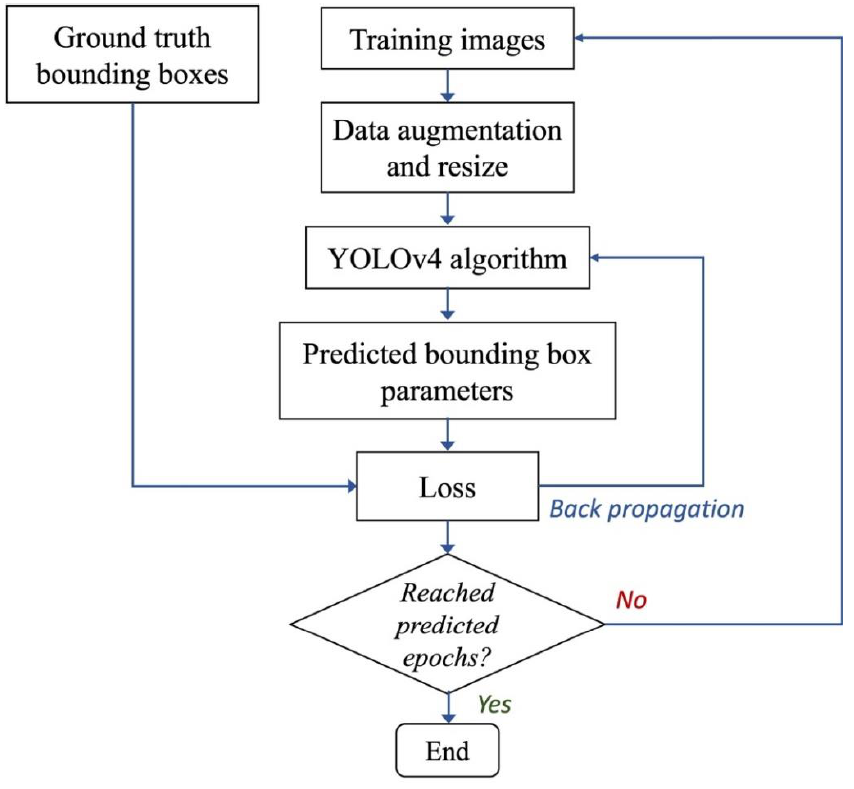
Figure 6. Training Figure 6. Training phase.